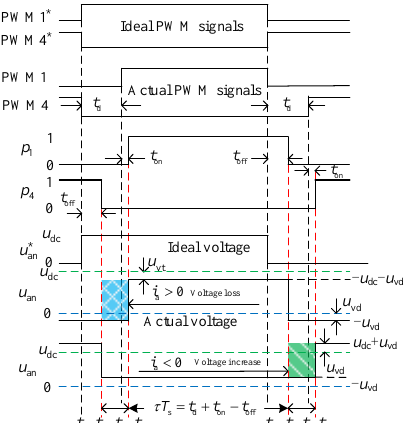
Figure 5. The harmonics distribution without deadtime and conduction voltage drop. ( a ) u ab ; ( b ) i as . If the switching on delay t on and off delay t off are considered, the dead time t d should be added to prevent the short circuit of the DC battery, the actual switching signals of S 1 and S 4 are noted as p 1 and p 4 , which are shown in Figure 6, an obvious timing error can be seen. At present, the low-order harmonic distribution of the stator current is shown in Figure 7a. Compared to Figure 5b, the 5th and 7th harmonics increase significantly. After setting the conduction voltage drops of the switching tube and body diode, noted as u vt and u vd , respectively, the 5th and 7th harmonics further increase, which is shown in Figure 7b. The output voltage u an of phase a in a switching period T s is shown in Figure 6, there is a nonlinear error ∆ u an between u an and the ideal voltage 𝑢 an∗ , and ∆ u an is affected by the polarity of i as , which is expressed as: dc = dc (1) ∆ u = + − + an where τ = ( t d + t on − t off )/ T s , d a is the duty cycle. These low-order harmonics will increase the torque ripple. If the frequencies of these lower-order harmonics are close to the natural frequencies of the IM, the resonance will occur and the mechanical performance of the IM will deteriorate.